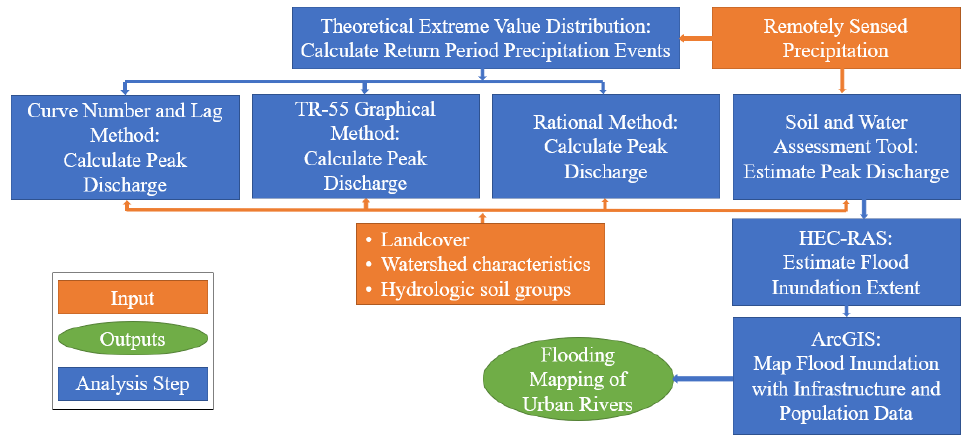
Figure 2. Schematic of the